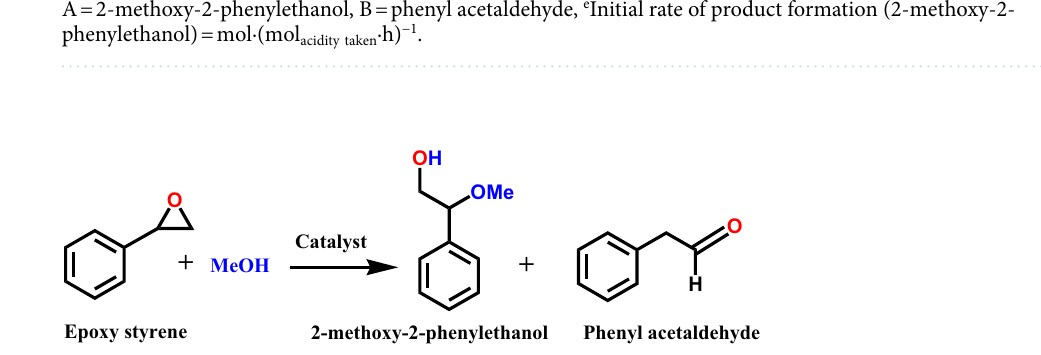
Table 2. Catalytic activity of different catalysts for alcoholysis of epoxy styrene with methanol. Reaction conditions: epoxy styrene = 2 g, methanol = 5.3 g (mole ratio = 1:10), catalyst = 44 μmoles of acidic sites,